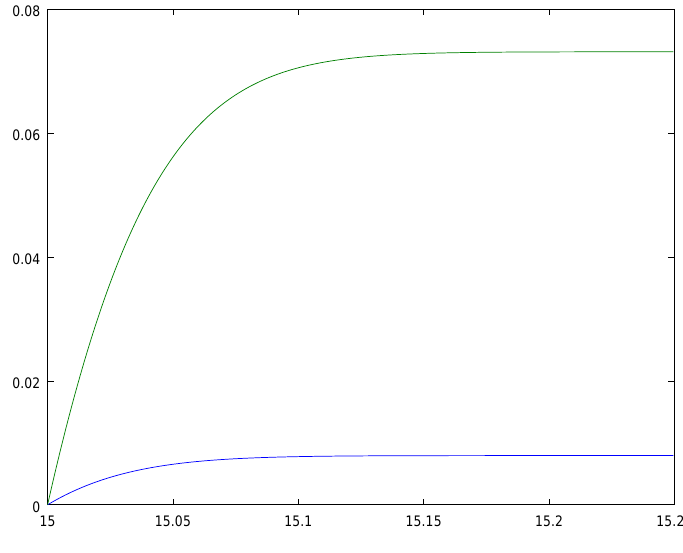
Figure 5. Example 2 ( t 0 = 15). Functions q 0 ( t ) (green) and q